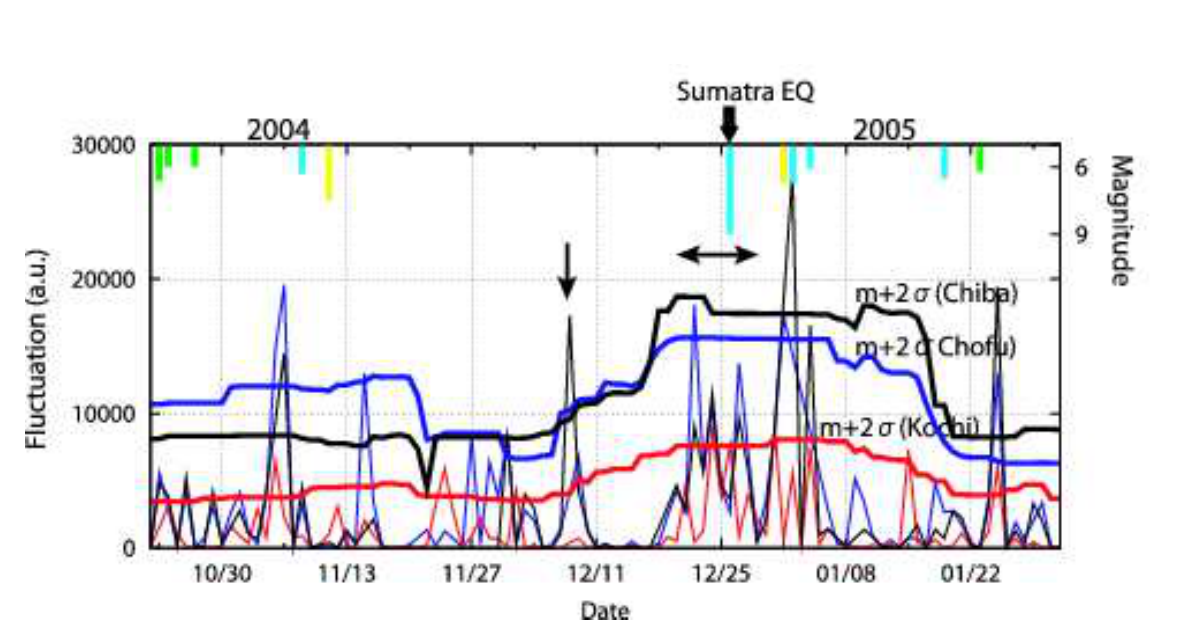
Figure 7. Temporal evolution of VLF amplitude nighttime fluctuation (dA 2 ) at the three observing stations (Chofu (Blue), Chiba (Black), and Kochi (Red)). The red line indicates (m (mean)+2 σ ( σ : standard deviation)) at Chofu, and the corresponding lines refer to Chiba and Kochi. The earthquake with magnitude greater than 6.0 is plotted downward, and the earthquakes during the restricted period of November, 2004 to May, 2005 are characterized by different colors (color indicates the